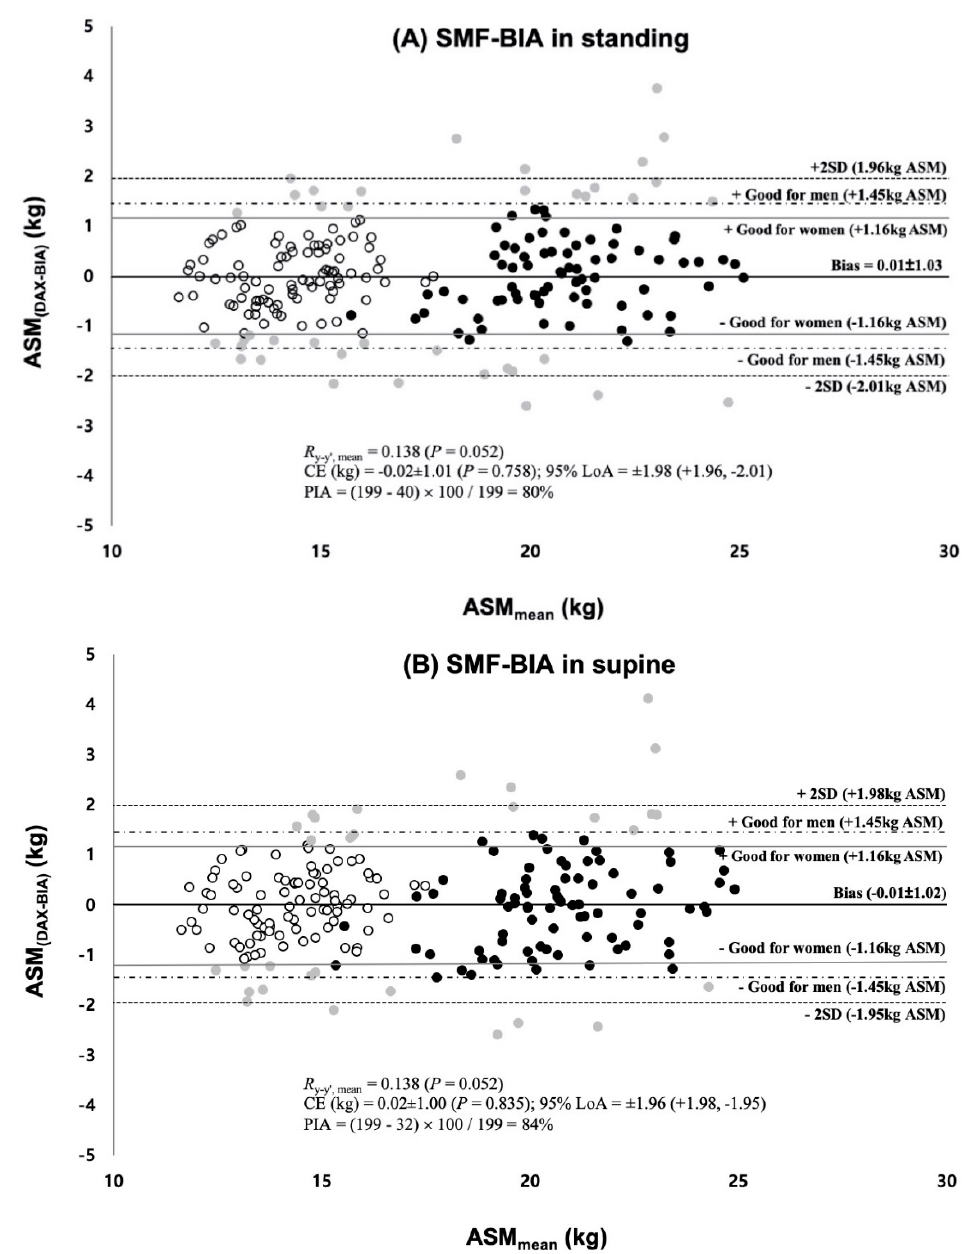
Figure 3. Bland–Altman plot of residual scores and mean difference between the measured and predicted ASM; ( A ) Residuals and mean difference from the standing BIA prediction equation ( B ) Residuals and mean difference from the supine BIA prediction equation; R y-y’, mean = concordance correlation coefficient between the residuals and the means of the measured ASM and predicted ASM; LoA = Limits of Agreement in ± 1.96SD; PIA = Percentage of individual agreement; = women within 1.16kg ASM,